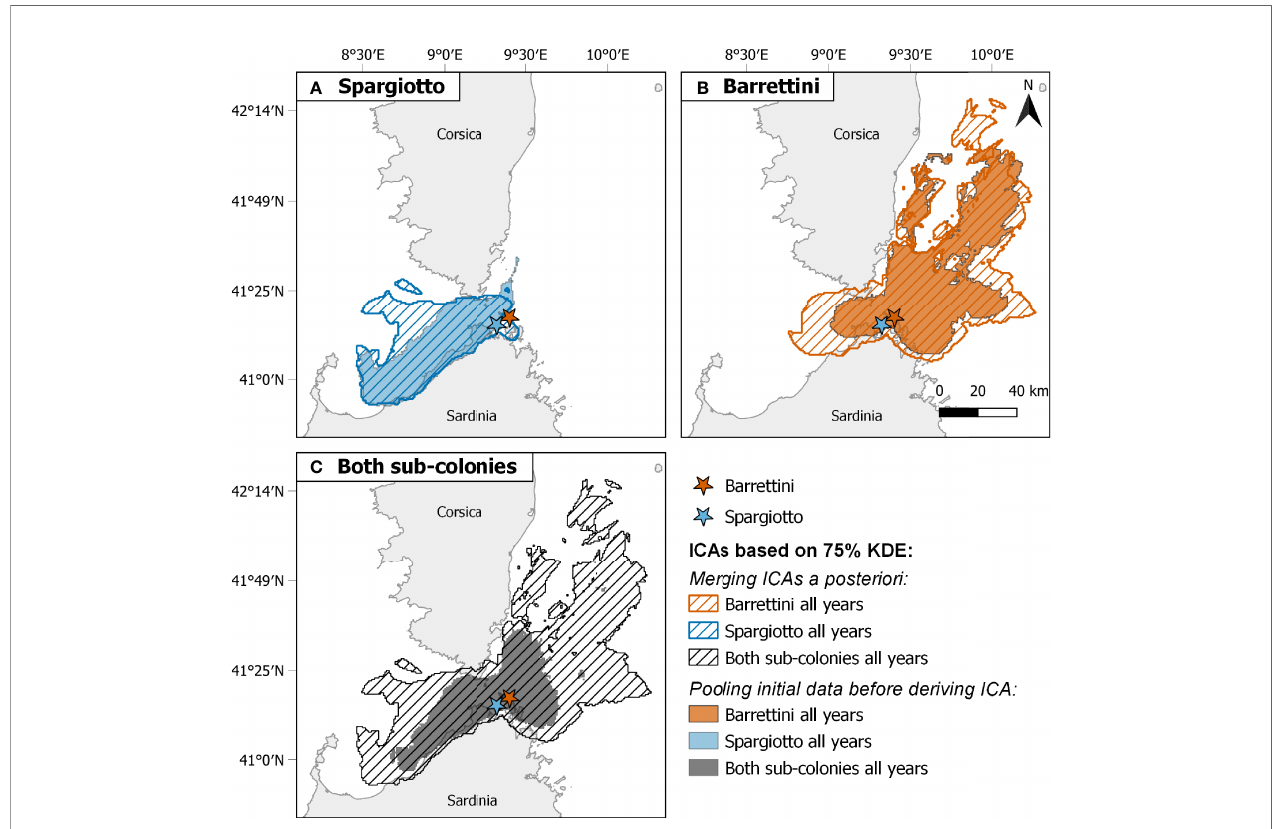
FIGURE 4 | Comparison of among-year and between-sub-colony Important Conservation Areas identi fi ed with two different methods: merging a posteriori ICAs derived from different years and/or sub-colonies (dashed areas) or pooling data before deriving a single corresponding ICA ( fi lled areas). Comparisons are shown for (A) Spargiotto, (B) Barrettini, and (C) both sub-colonies. ICAs are based here on 75% Kernel Density Estimates. Sample size of trips considered: 75 for Spargiotto, 124 for